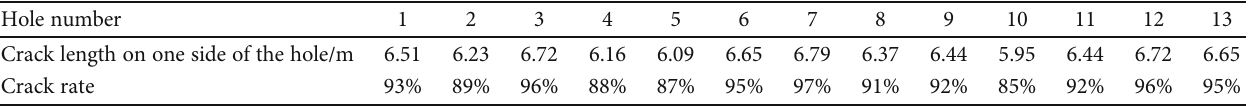
Table 4: The crack rates of the 13 blastholes in SCHB.